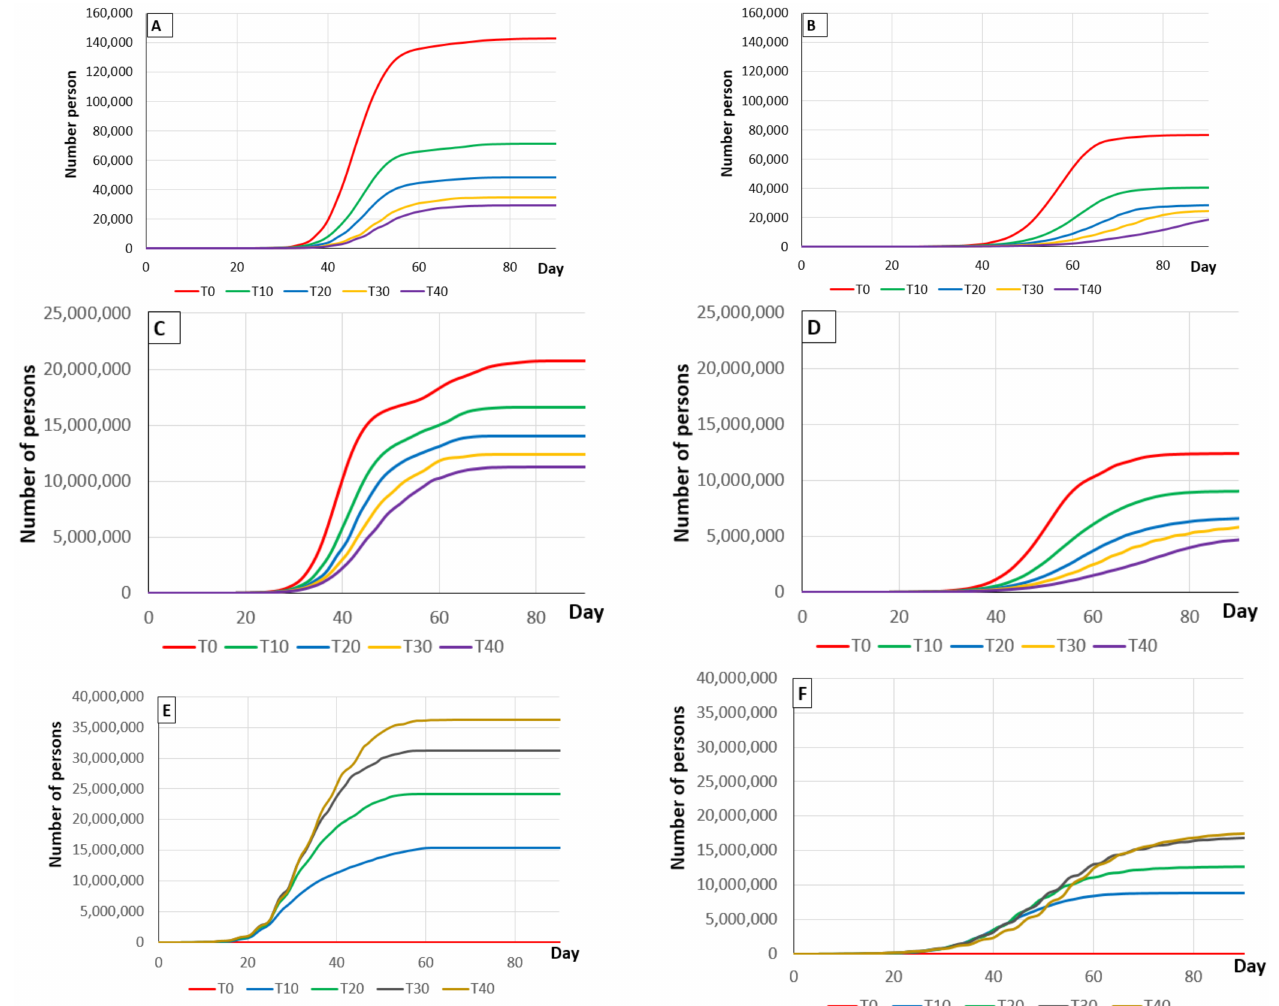
Figure 3. Graphs ( A , B ) show the progress of the death toll in Spain depending on the percentage of traced contacts (from 0% (T0) to 40% (T40)) without and with the application of social measures, with 19.6% of the population protected by vaccination, using a PDP model over an 80-day period. Graphs ( C , D ) show the number of people recovering depending on contact tracing (from 0% (T0) to 40% (T40)) without and with the application of social measures, with 19.6% of the population protected by vaccination using a PDP model over an 80-day period. Graphs ( E , F ) show the number of diagnostic tests carried out depending on contact tracing (from 0% (T0) to 40% (T40)) without and with the application of social measures, with a 19.6% of the population protected by vaccination, using a PDP model over an 80-day period. Table 9. Diagnostic tests performed as a percentage of the Spanish population (46,014,554) when vaccination protects 19.6% of the population and contact tracing follows up 10% to 40% of contacts with an infected